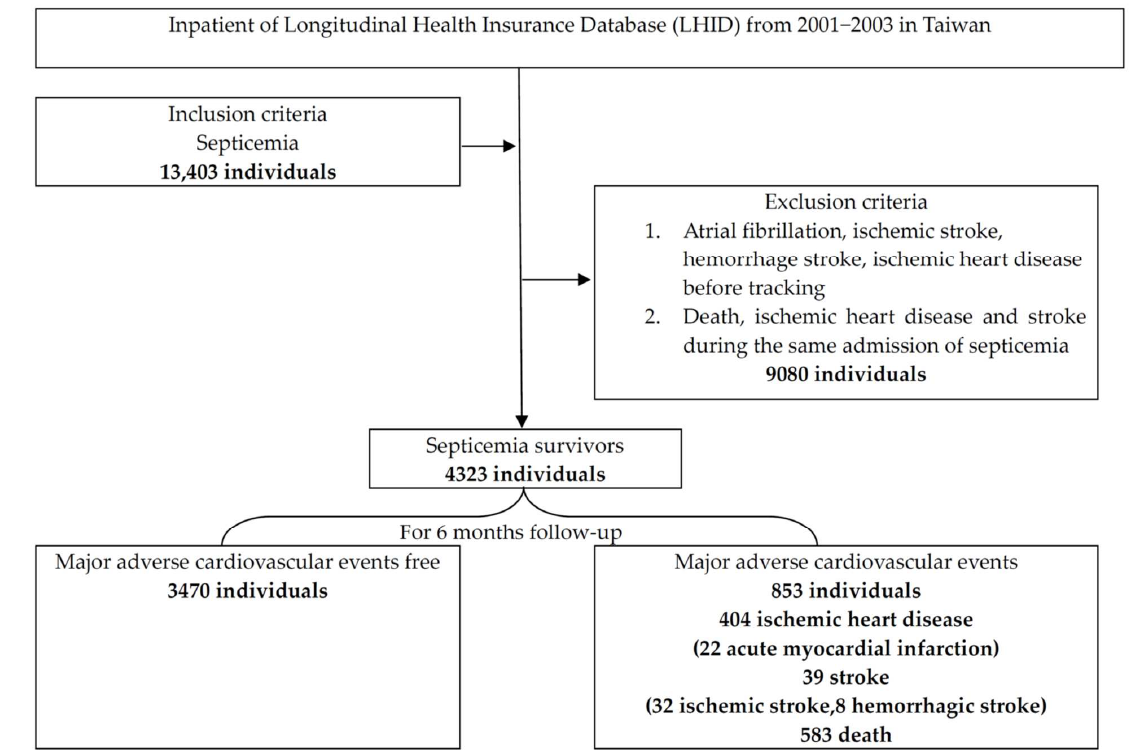
Figure 1. The flowchart of this study. Descriptive statistics were performed using the chi-square test (χ 2 ) for categorical factors and Student’s t test for continuous variables. The cumulative incidences of IHD between the NOAF group and NOAF-free group were analyzed by the log-rank test of Kaplan–Meier curves. The HR of MACEs and IHD for risk factors was determined by